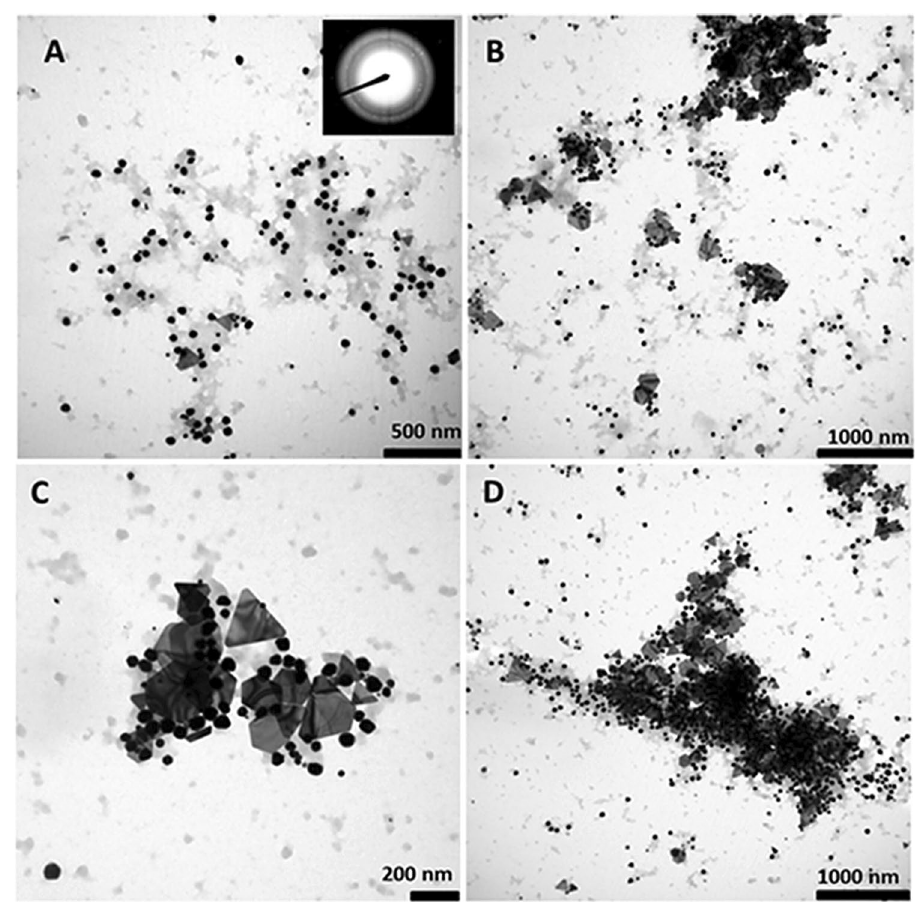
Figure 3. TEM analysis reveals phytosynthesised Au1 NPs shape and size heterogeneity. Crystalline Au NPs were confirmed by SAED. ( A ) The majority are quasi-spherical with some presence of triangular ( B ) and hexagonal ( C ) particles evident. Au NPs were detected both isolated and in groups ( D ).